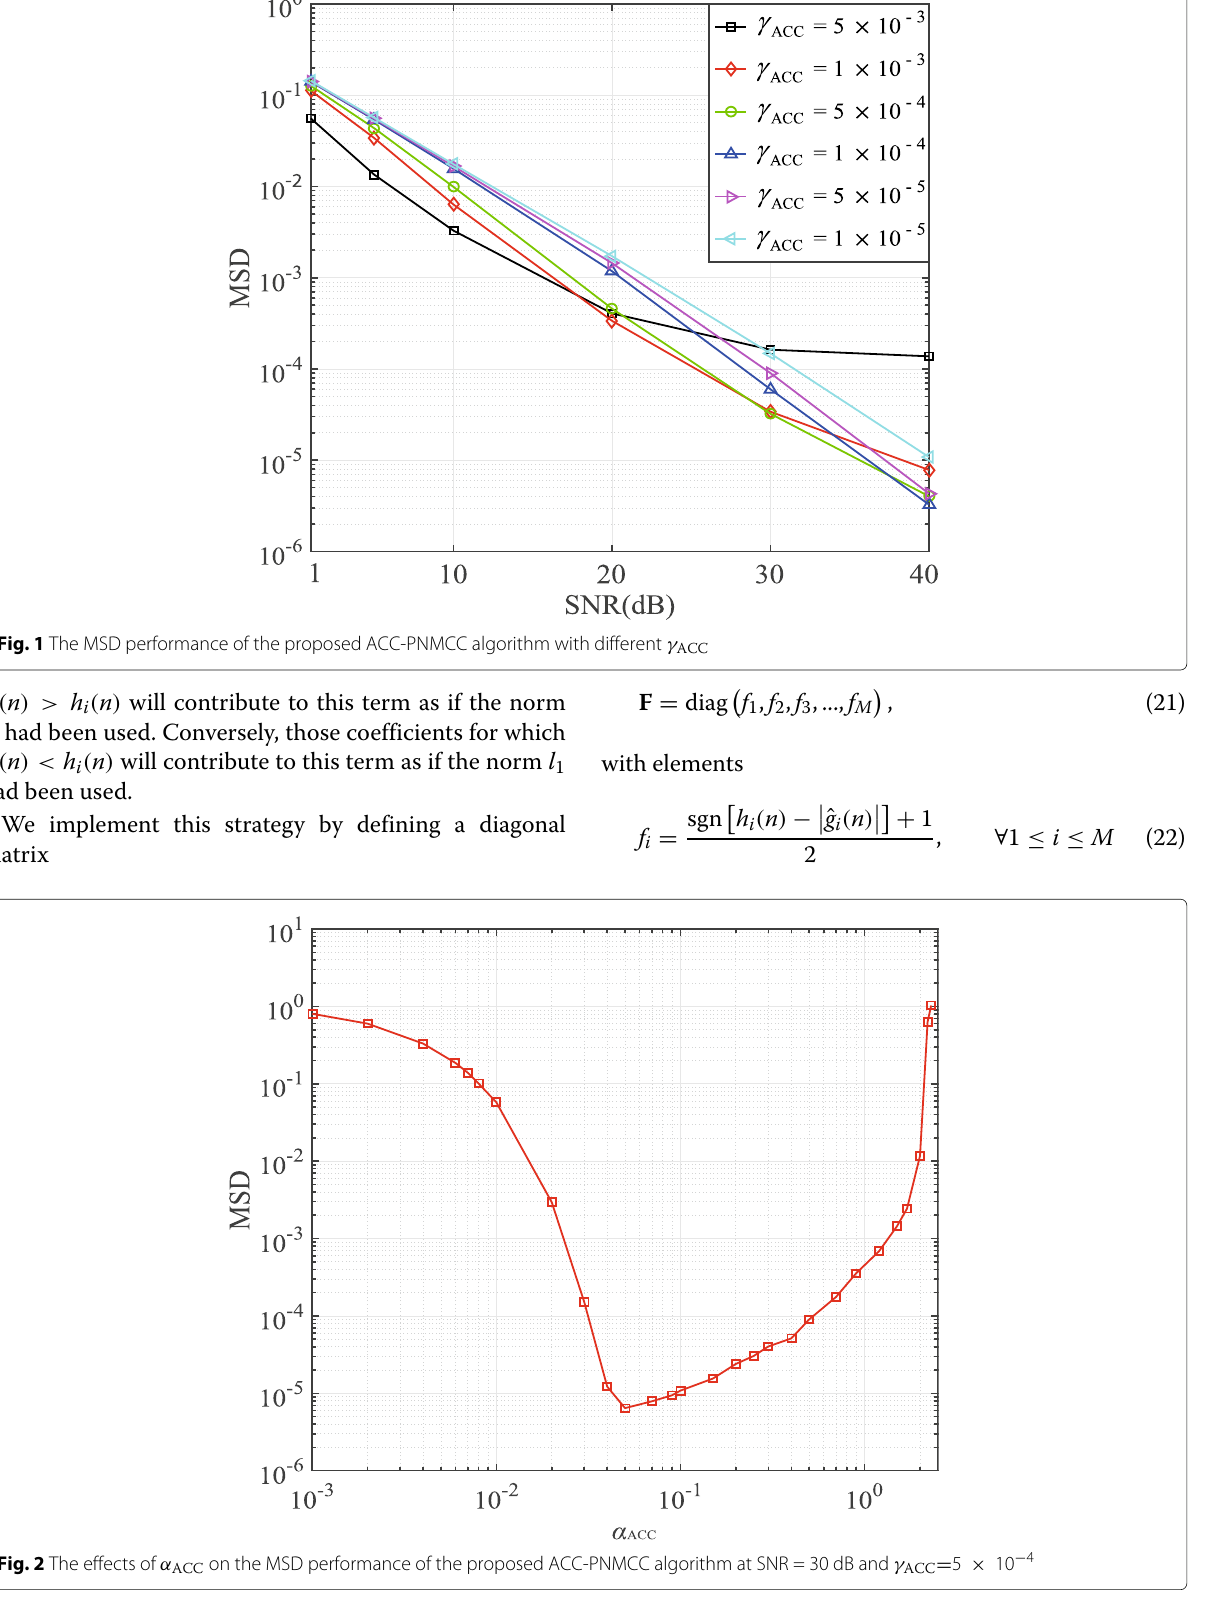
Fig. 2 The effects of α ACC on the MSD performance of the proposed ACC-PNMCC algorithm at SNR = 30 dB and γ ACC = 5 × 10 −